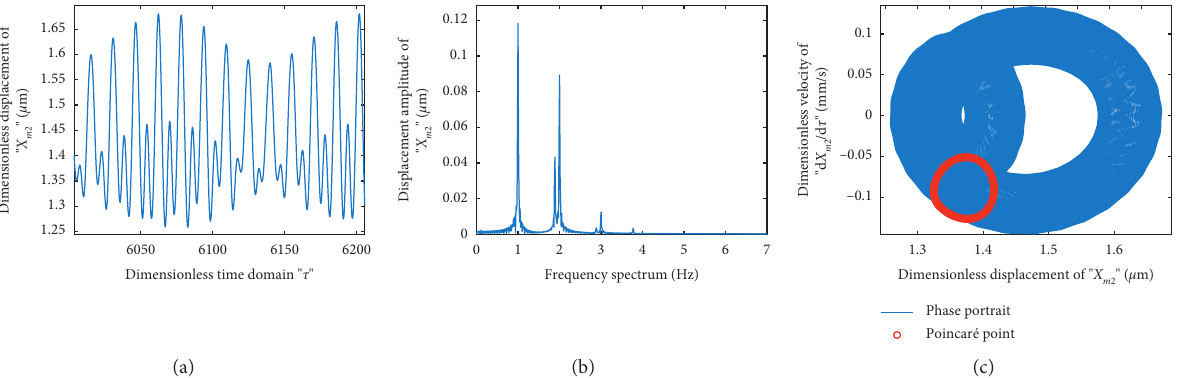
Figure 13: The dynamic response of system X m 2 at 16370rpm. (a) Time-domain response. (b) FFTspectrum. (c) Phase plane and Poincar´e point.